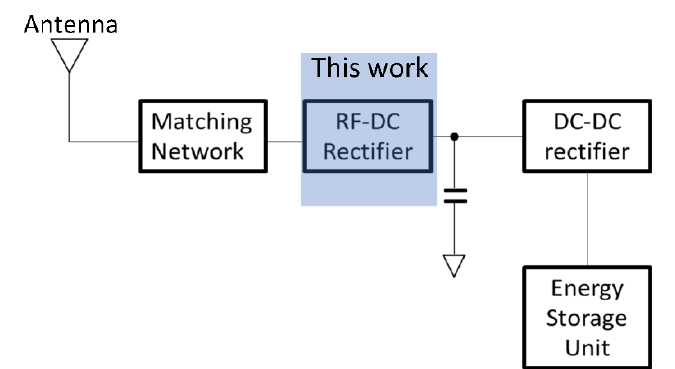
Figure 1. RF Energy Harvesting (RFEH) system description and specific focus on the rectification or RF-DC conversion stage that is the focus of this work.